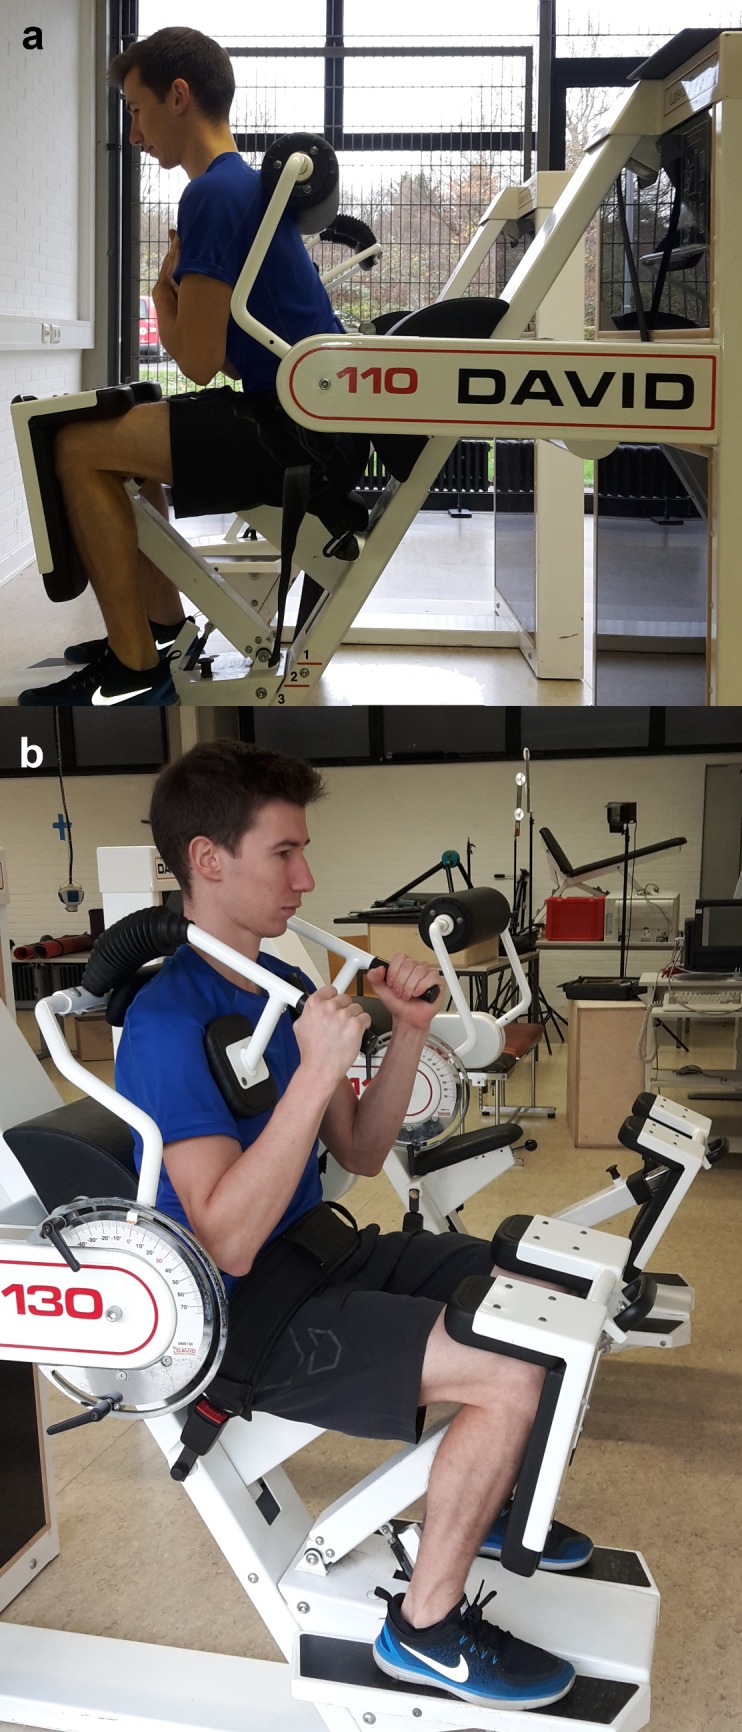
Illustration of the back extension (a) and back flexion (b).